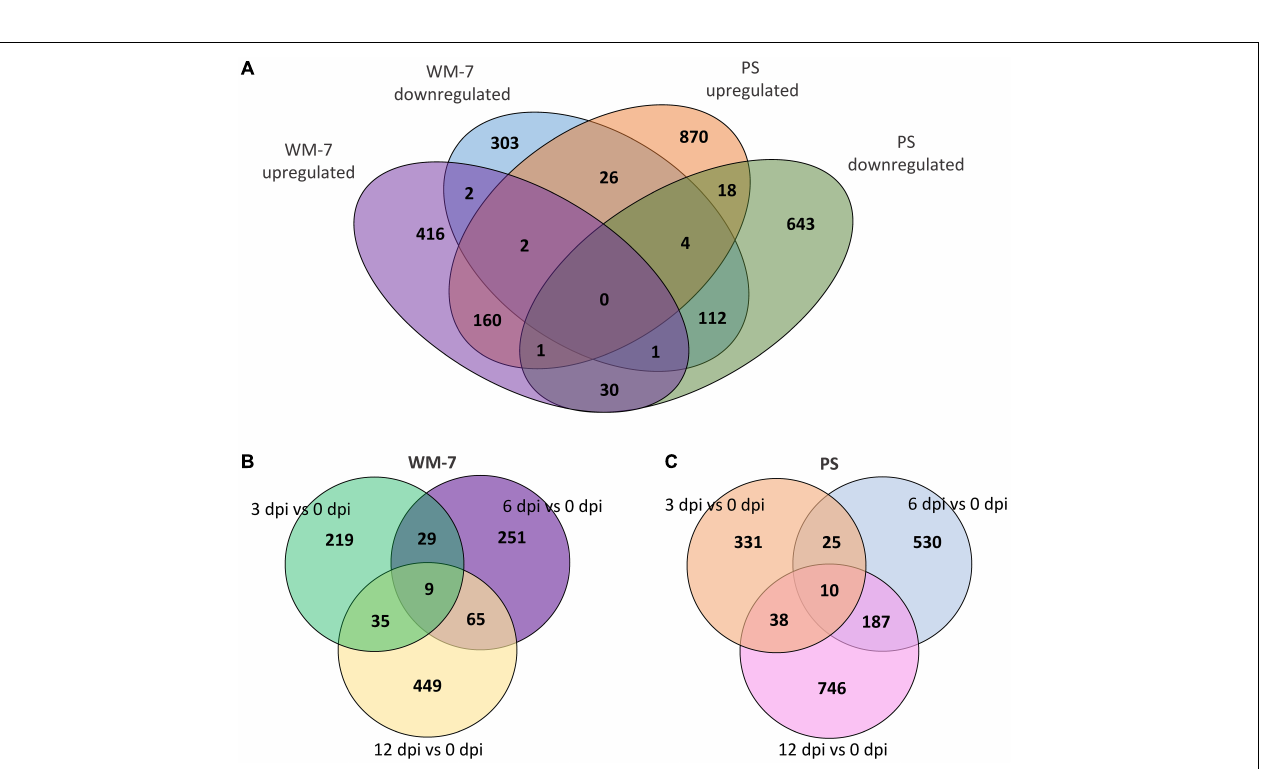
FIGURE 4 | Venn diagrams representing common and specific up and down DEGs identified in WM-7 and PS (A) ; common and specific DEGs at 3, 6, and 12 dpi in WM-7 (B) and PS (C) .